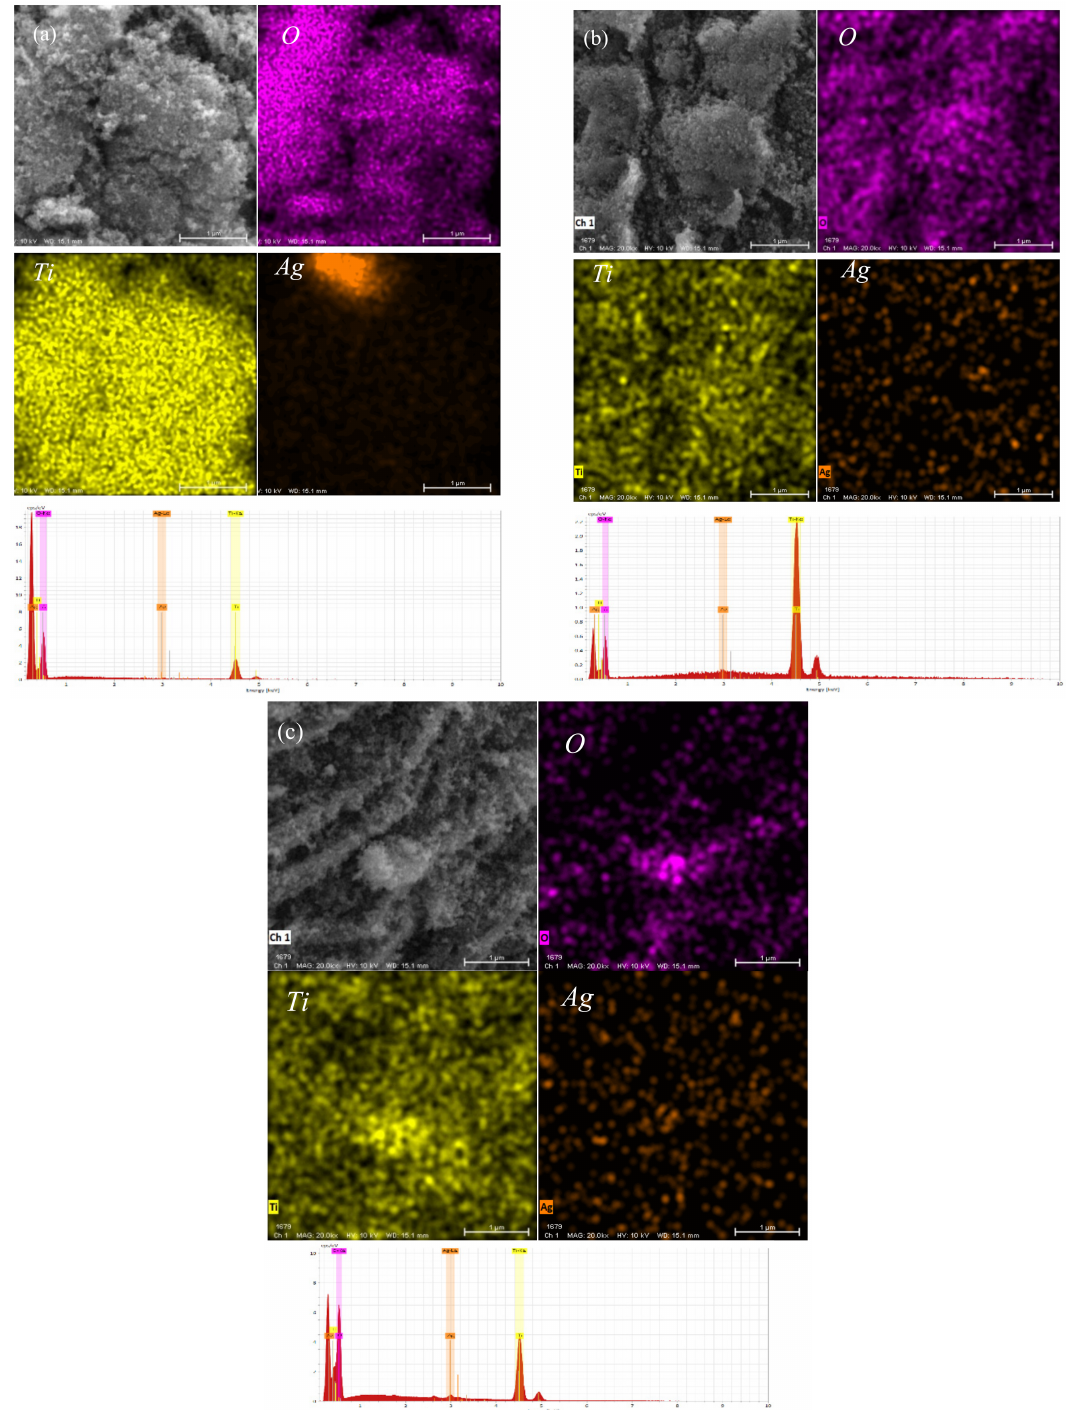
Figure 4. Elemental mapping and EDS analysis of Ag-TiO 2. ( a ) 1%Ag-TiO 2 . ( b ) 2%Ag-TiO 2 . ( c ) 5%Ag-TiO 2